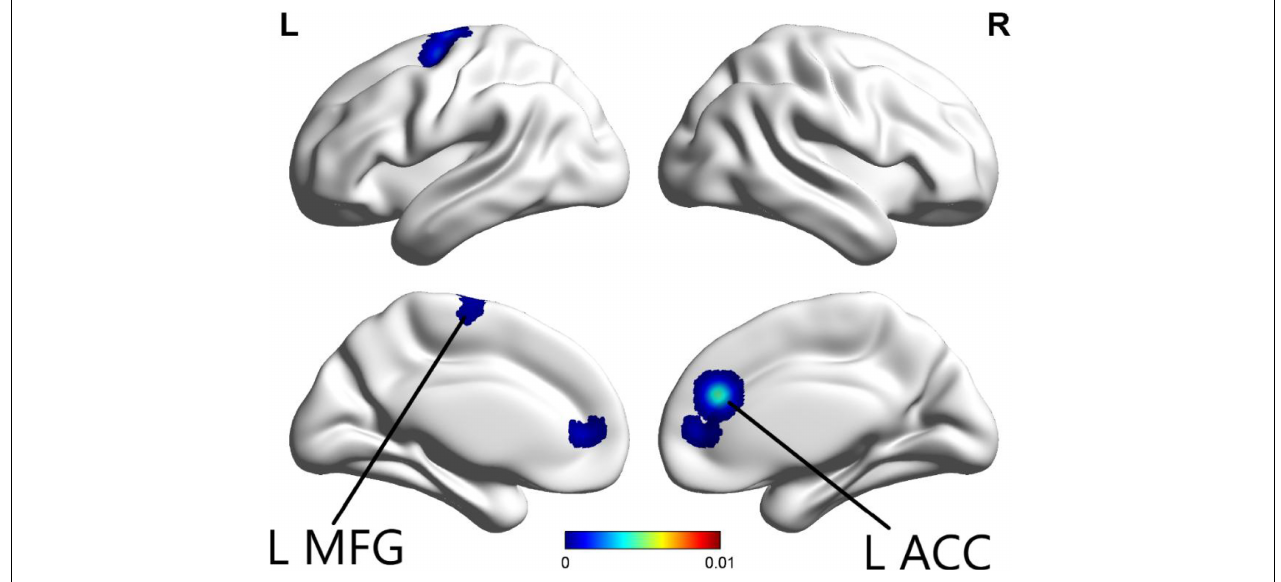
FIGURE 2 | In the cognition paradigm, significantly decreased activations across the left anterior cingulate (L ACC) and left middle frontal gyrus (L MFG) were found in patients with psychiatric disorders after CBT ( p <